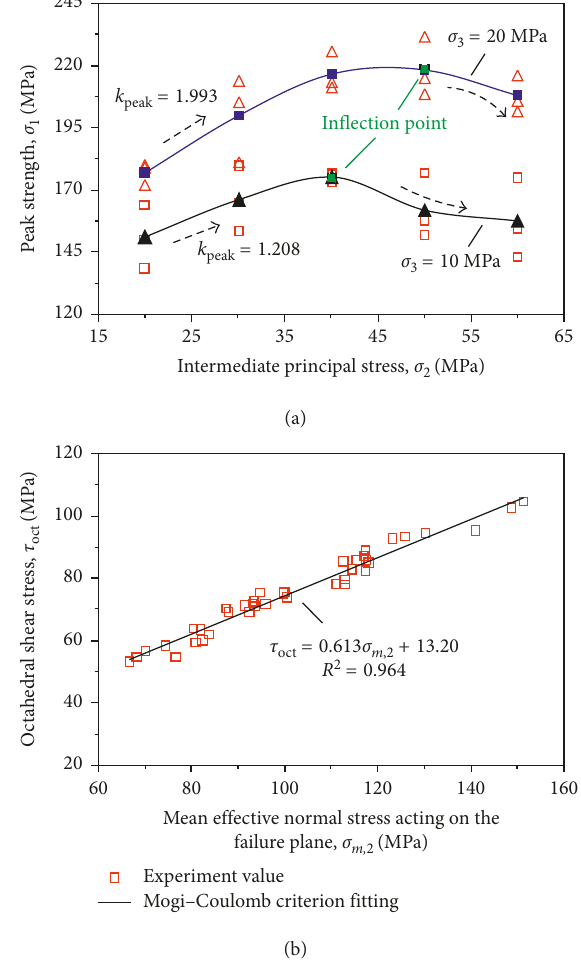
Figure 4: True triaxial strength for sandstone: (a) variation of peak compressive stress σ 1 as a function of σ 2 for the constant values of σ 3 10 MPa and σ 3 20 MPa; k peak represents the slope of the (cid:31) (cid:31) peak strength with increasing σ 2 ; (b) the best-fit linear function true triaxial strength criterion (Mogi–Coulomb Criterion) based on all experimental results in terms of τ oct versus σ m, 2 .